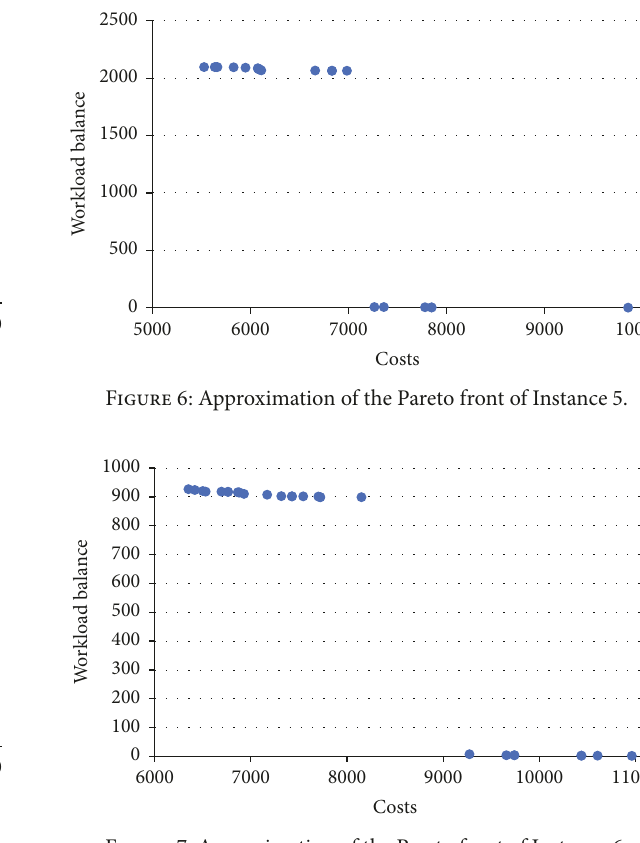
Figure 7: Approximation of the Pareto front of Instance